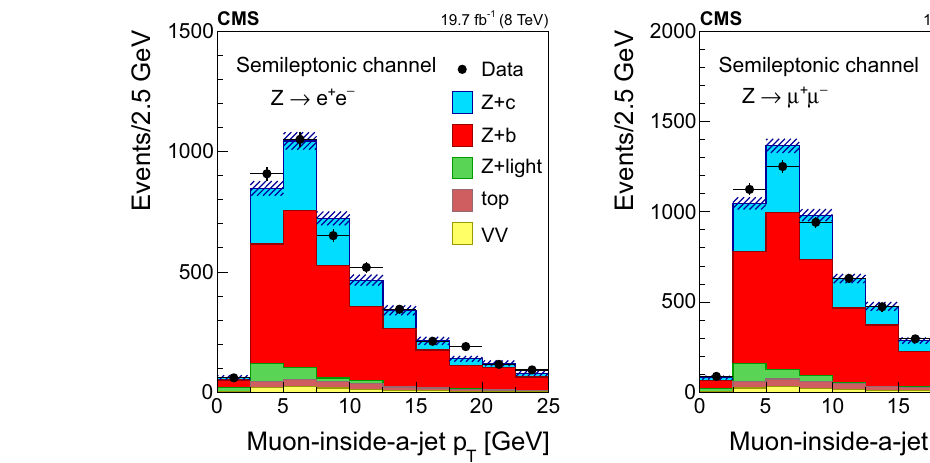
μ + μ − (right). The data are compared with the predictions of the MC simulations, which are composed of Z + b events ( ≈ 65%), Z + c events ( ≈ 25%), Z + light flavour ( (cid:3) 5%), and other backgrounds, such as tt and diboson production ( ≈